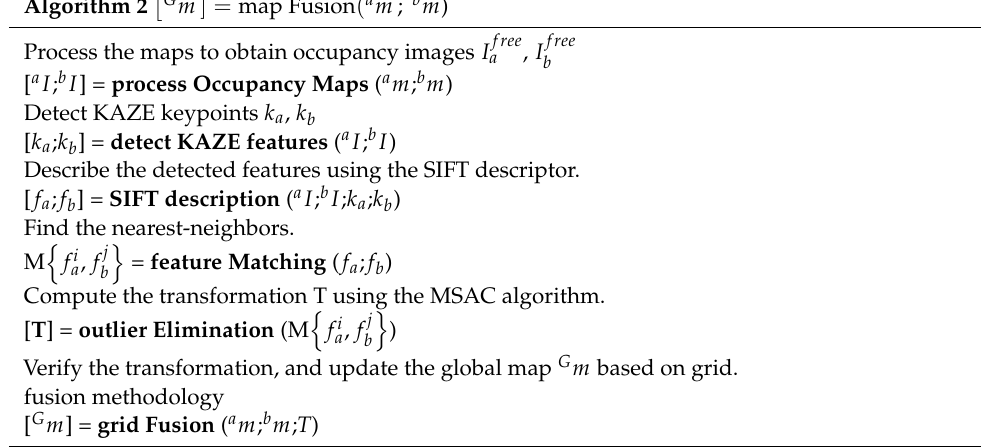
Figure 10. Qcar by